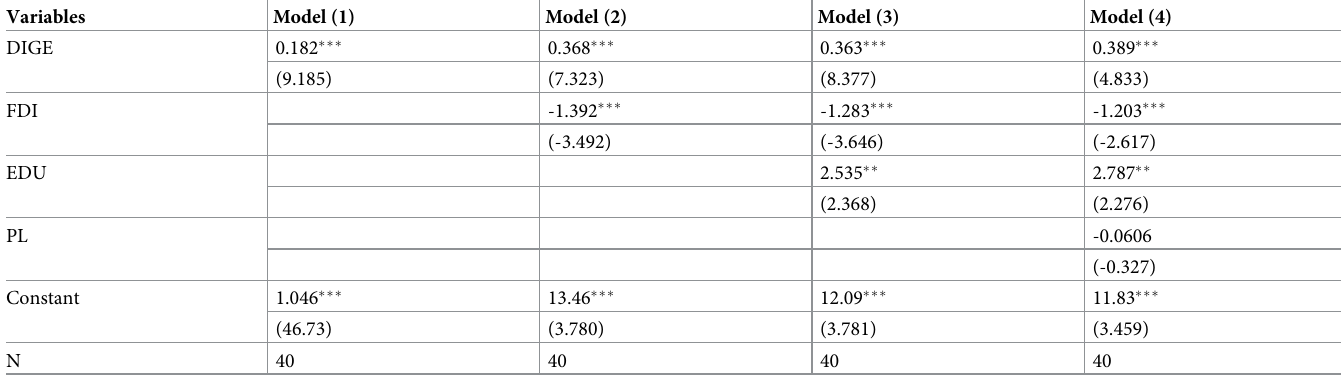
Table 7. Regression results of digital economy on